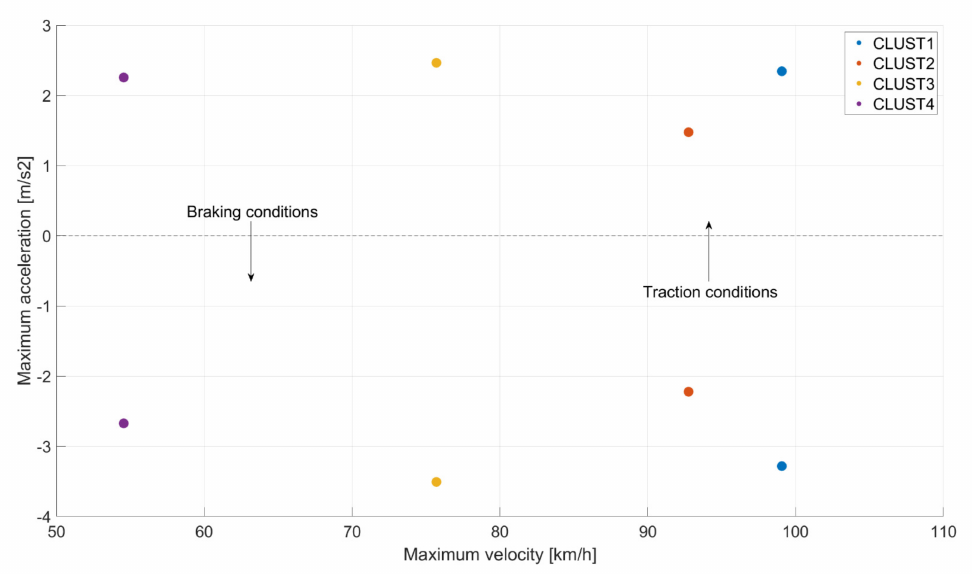
Figure 6. Comparison of the maximum accelerations realized in CLUST1, CLUST2, CLUST3 and CLUST4.